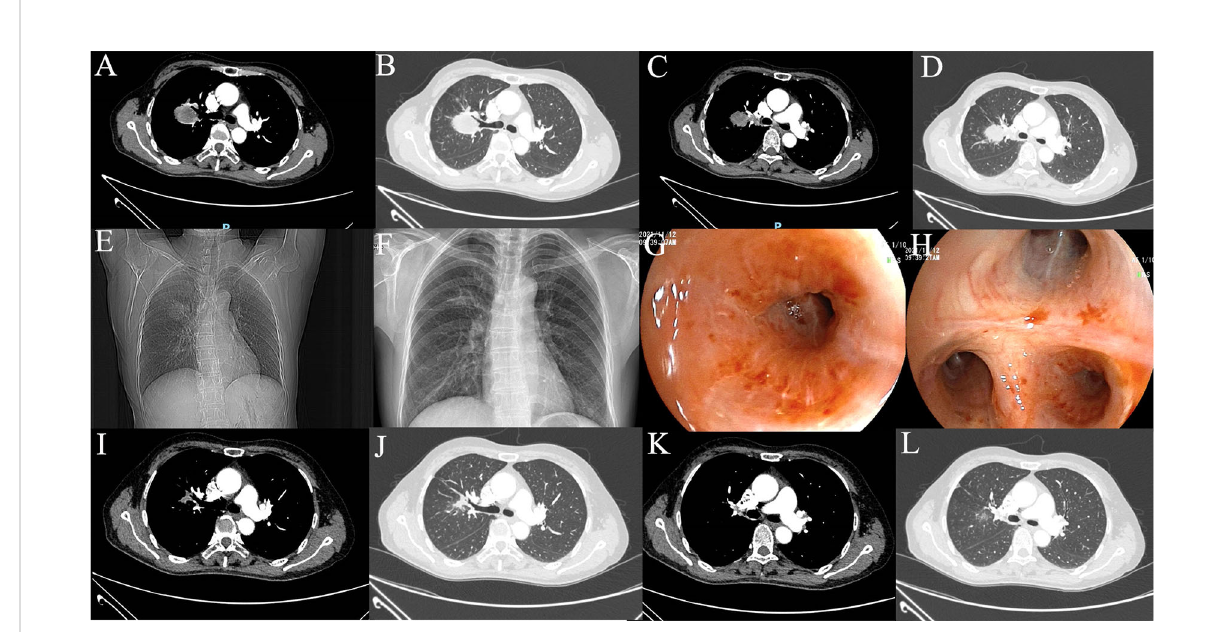
FIGURE 2 Imaging examination. (A – D) Preoperative CT scan; (E) Preoperative DR image; (F) DR image after one cycle of neoadjuvant therapy; (G, H) Preoperative fi beroptic bronchoscopy image; (I – L) CT image after 2 cycles of neoadjuvant